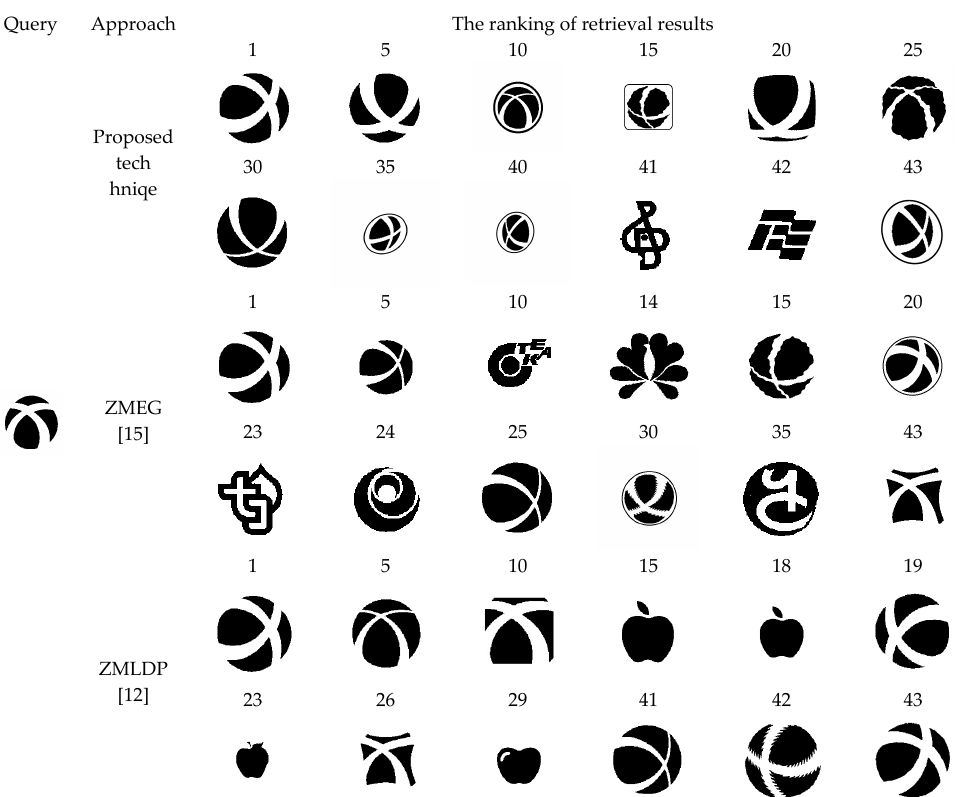
Figure 13. Comparison of the ranking performance for the query in class 1.